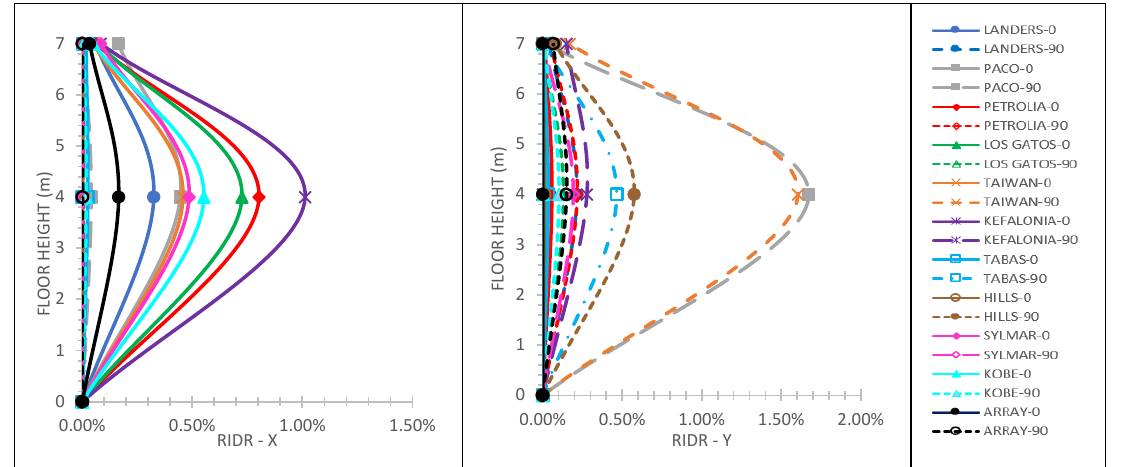
Figure 3. RIDR along X ( left ) and Y ( right ) horizontal directions of the two-story mixed building, considering the fixed connection of the steel structure to the r/c one.